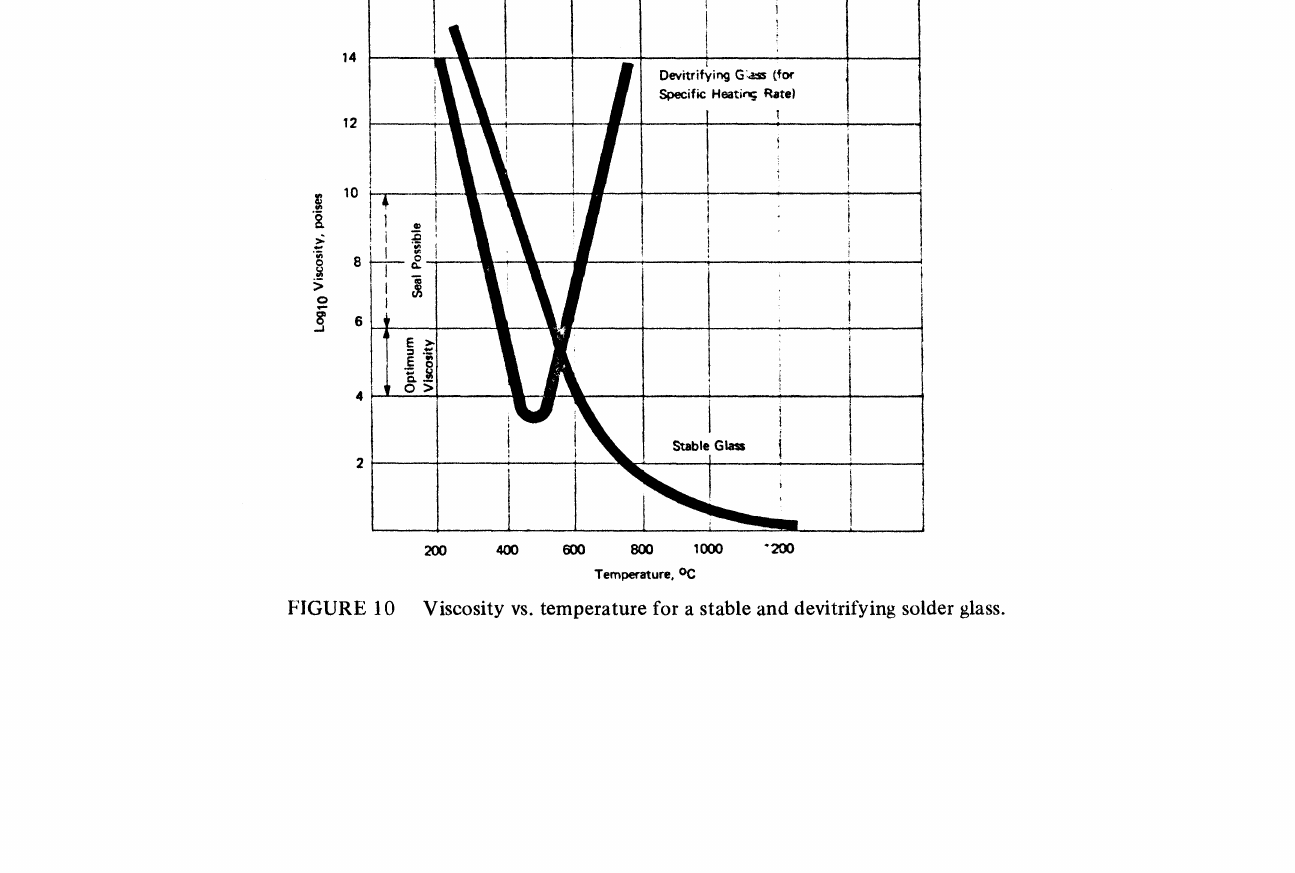
FIGURE 10 Viscosity vs. temperature for a stable and devitrifying solder